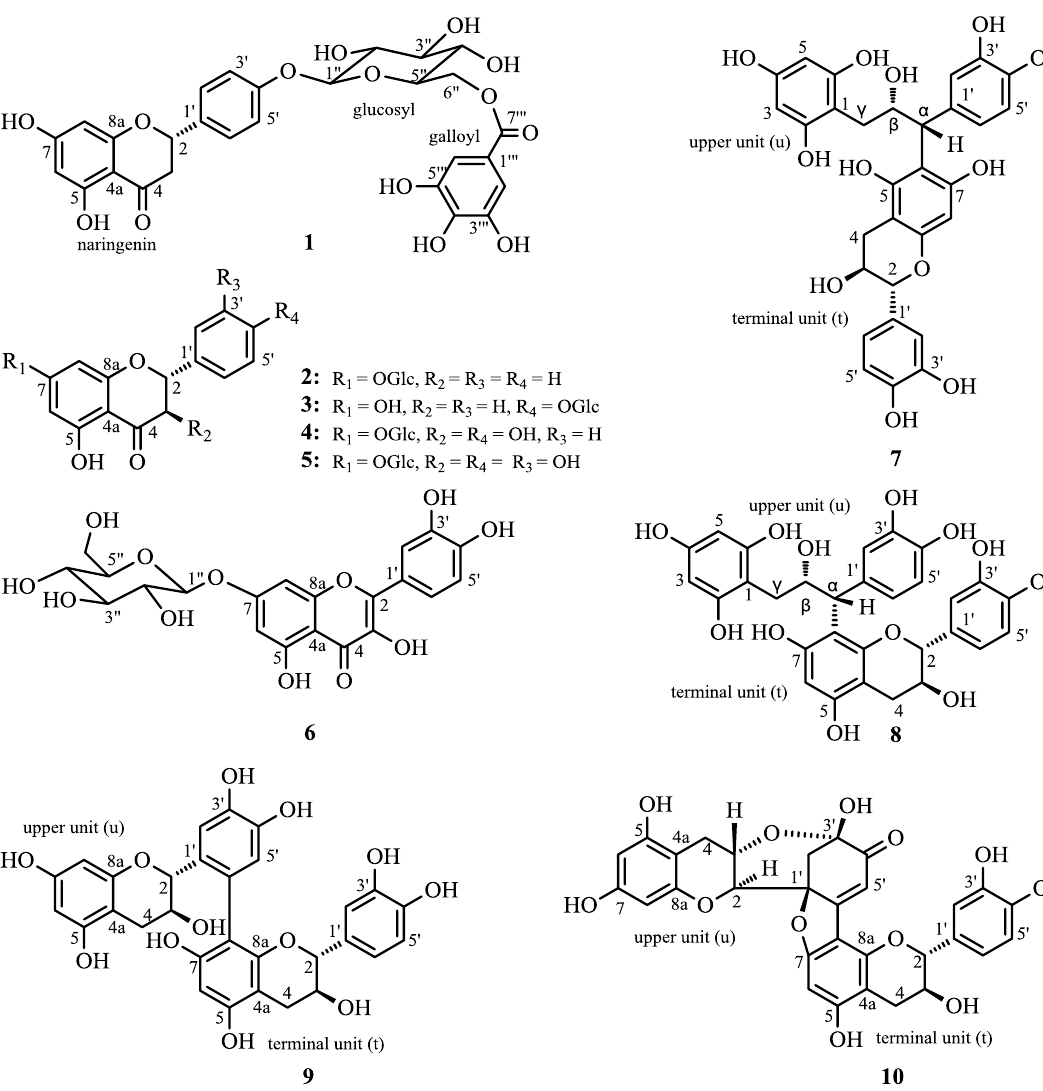
Figure 1. Structures of compounds 1 – 10